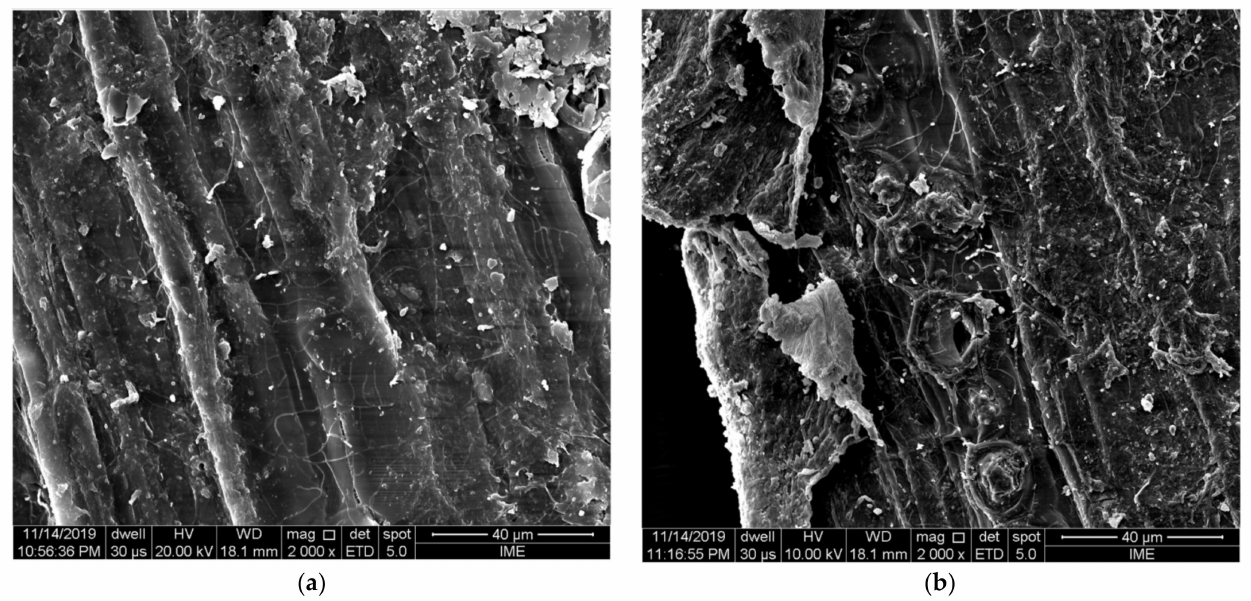
Figure 3. Fiber defibrillation: ( a ) untreated; ( b ) with treatment with NaOH solution